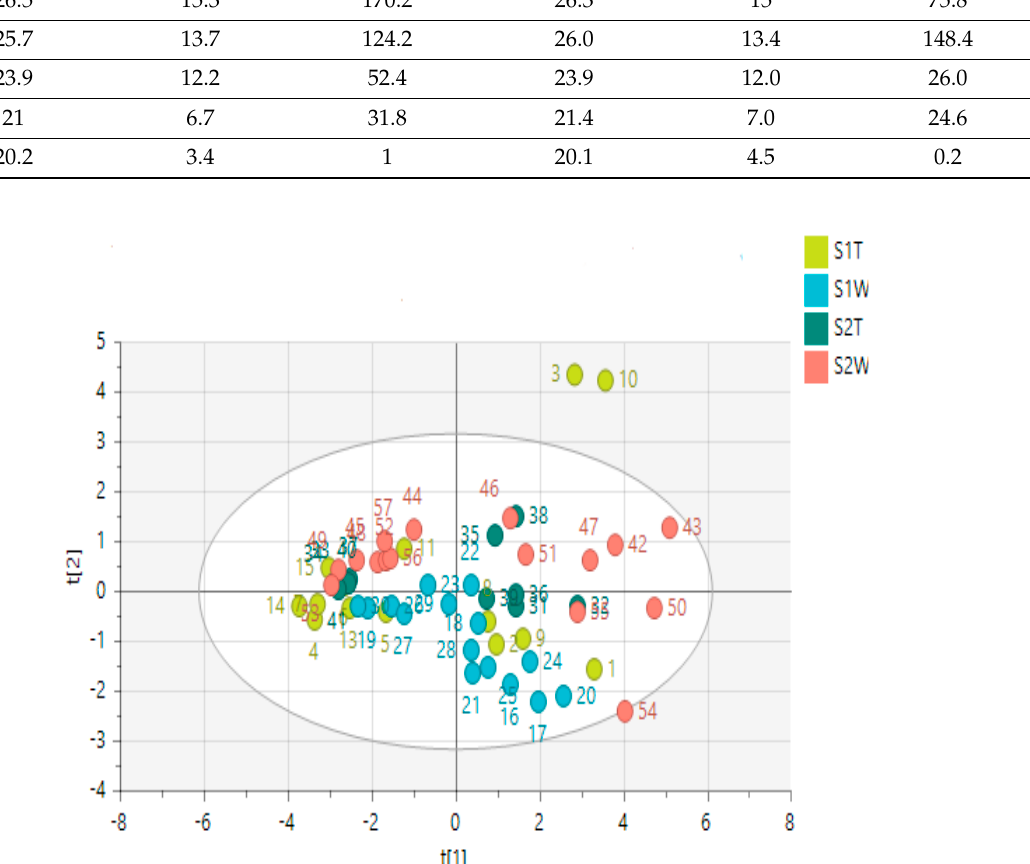
Figure 1. PCA score scatter plot showing component 1, x − axis (PC1 = 54.6%), and component 2, y − axis (PC2 = 14.6%), of H. aureonitens leaves and stems collected during spring and autumn at Telperion and Wakefield. S1T = spring, Telperion; S1W = spring, Wakefield; S2T = autumn, Telperion; S2W = autumn, Wakefield. An OPLS-DA model was further constructed to facilitate the clustering and identifi- cation of metabolites relevant to the determination of differences between seasons and geographical locations (Figure 2A). A clear separation was then observed between sam- ples across seasons and locations. The model displayed a goodness of fit and predictability as presented by an R 2 X of 0.905, an R 2 Y of 0.727 and a Q 2 of 0.384, respectively. A response permutation test (with n = 100) was constructed in order to validate the predictive capa- bility of the computed OPLS-DA models. This statistical test compares the R 2 and Q 2 val- ues of the true model with those of the permutated model. The test is carried out by ran- domly assigning the two groups and then fitting the OPLS-DA models to each permuted class variable. The permutated models’ R 2 and Q 2 values are then calculated and com- pared to the true models’ values. The results show that the measured models have signif- icantly higher R 2 and Q 2 values (Figure 2B), implying that the calculated true OPLS-DA models for each dataset are statistically better relative to the 100 permuted models.